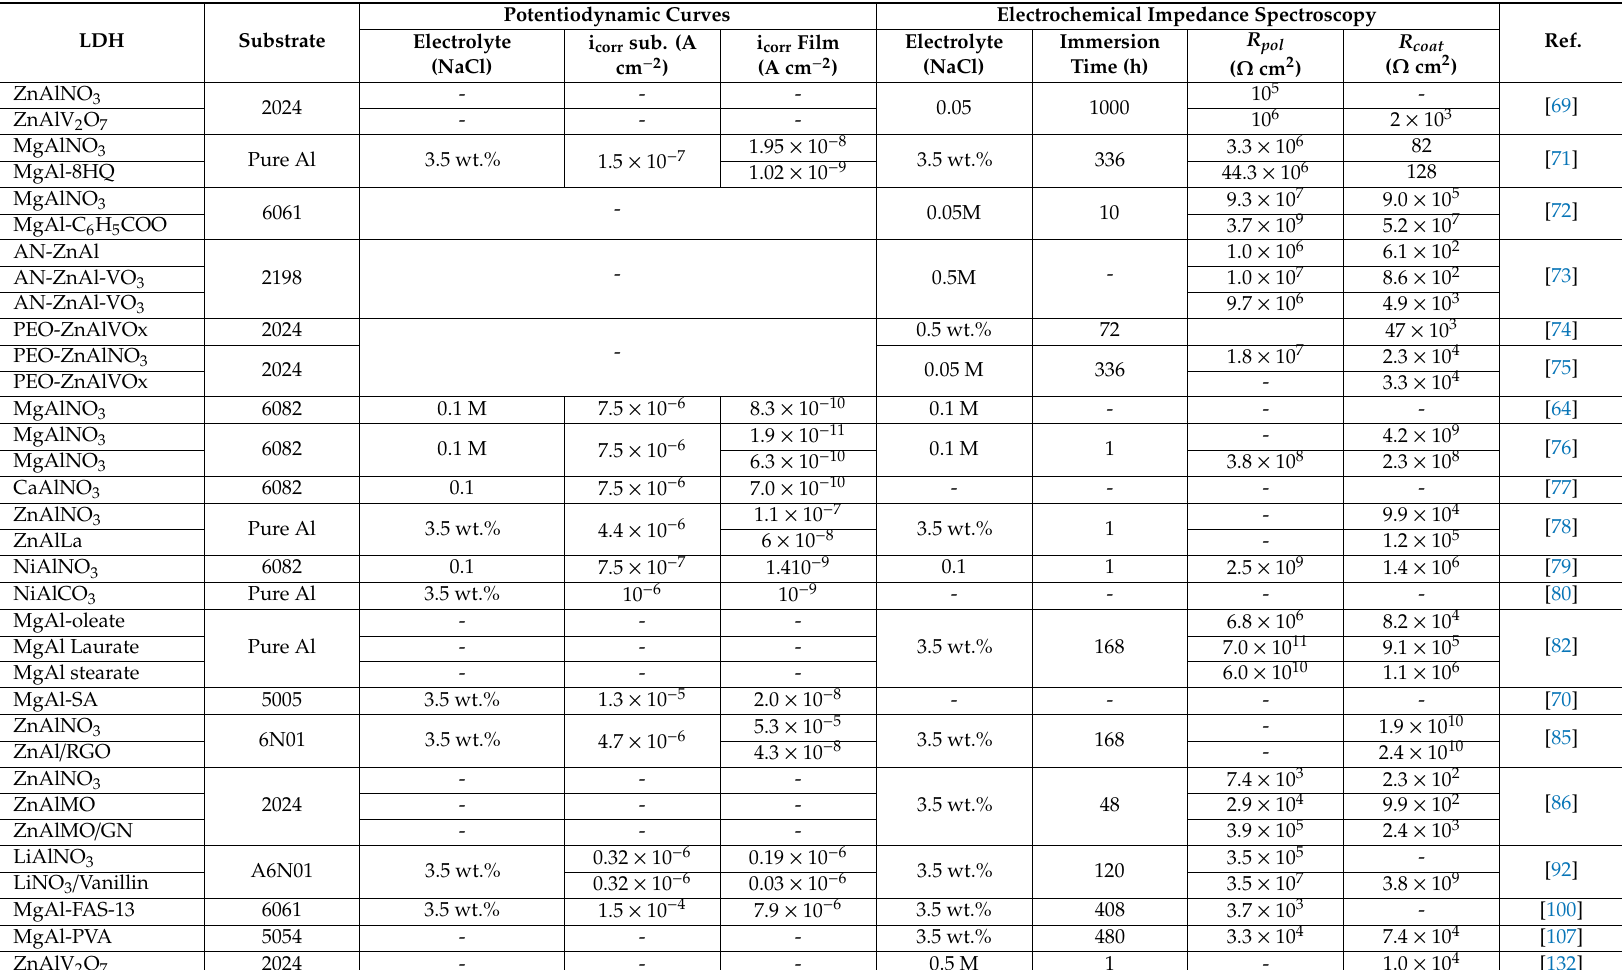
Table 2. LDH-based systems and measured corrosion resistance